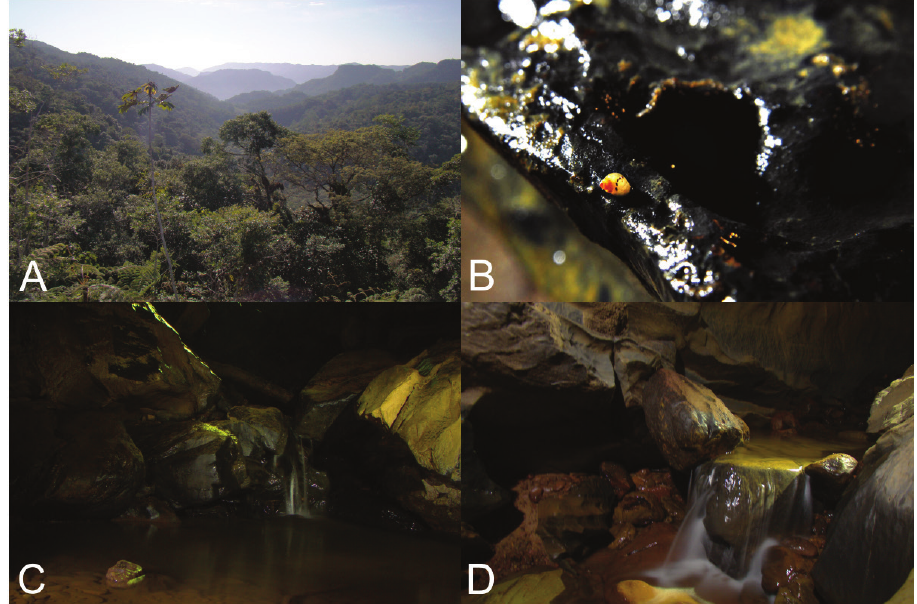
Figure 2. Landscape (Atlantic Rainforest) ( A ), Potamolithus sp. 5 in natural habitat, Santana cave ( B ) and subterranean streams ( C, D ) from Alto Ribeira karst area, Southeastern Brazil. Photographs: PP Rizzato ( A, C, D ), A Gambarini ( B